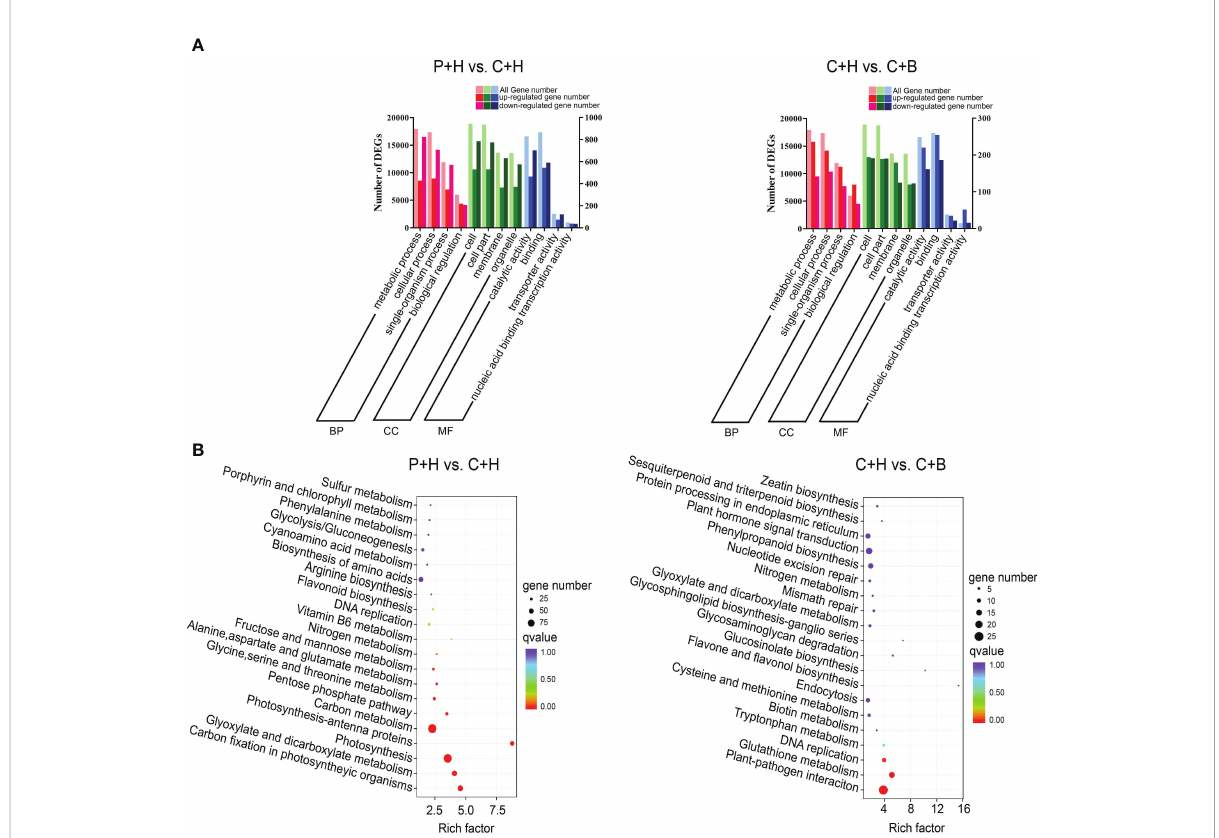
FIGURE 3 Enrichment analyses of DEGs. (A) GO analyses of DEGs in P+H vs. C+H and C+H vs. C+B in three main categories. The vertical axis on the left is all gene number. The vertical axis on the right is up- and down- regulated gene number. (MF, molecular function, CC, cellular component, BP, biological process). (B) KEGG pathway enrichment analyses of DEGs in P+H vs. C+H and C+H vs. C+B. P+H, PBS solution + H 2 O; C+H, CGMMV + H 2 O; C+B, CGMMV +